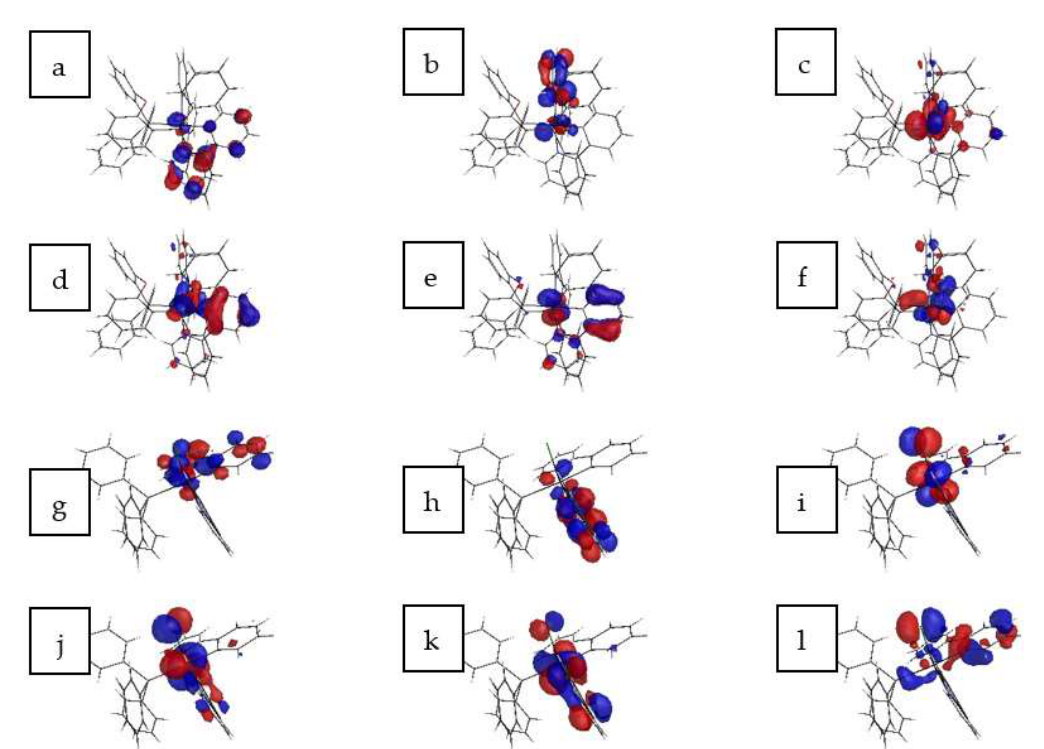
Figure 8. Frontier molecular orbitals of Ir(ppy) 2 (BPE) and Ir(ppy) 2 (TPP). ( a ) MO 161; ( b ) MO 160; ( c ) MO159; ( d ) MO 158; ( e ) MO157; ( f ) MO156; ( g ) MO117; ( h ) MO116; ( i ) MO 115; ( j ) MO 114; ( k ) MO 113; ( l ) MO 112. Table 3. Ir(ppy) 2 (BPE) percentage composition of singlet/triplet transitions and related molecular orbitals calculated at the RB3LYP/LANL2DZ level.